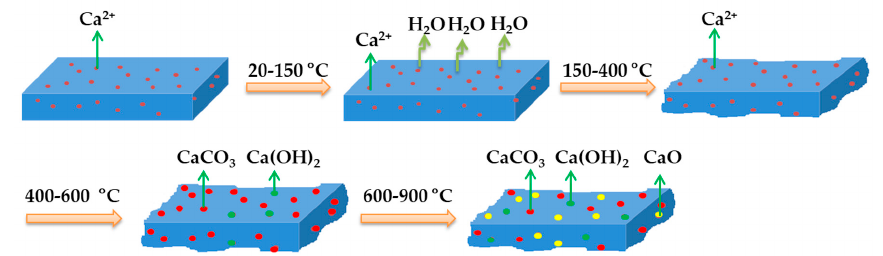
Figure 6. Schematic of the supposed thermal degradation mechanisms.